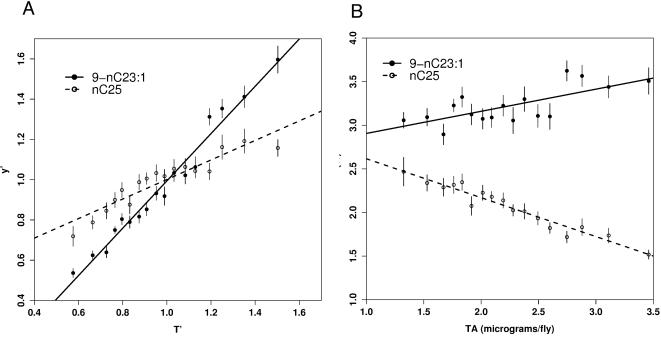
Test of RA model assumptions.(a) Plot of scaled abundance y′i
,j versus scaled total abundance T′i for monoene 9-C23∶1 (solid line) and n-alkane C25 (dashed line) in DD. Fitted slopes β′j are different from 1: slope β′j = 1.254 for 9-C23∶1 (s.e. = 0.0345, t = 7.37, df = 346, p<1e-12) and β′j = 0.483 for C25 (s.e. = 0.0365, t = −13.6, df = 345, p<1e-16). Each point is mean±1 s.e. of 20–22 observations over 24 hours. Abscissa and ordinate are dimensionless.(b) Plot of RA versus TA over 24 hours. RA is dimensionless, TA is µg/fly. 9-C23∶1 – filled circles, solid line; C25 open circles, dashed line. RA for C25 is less in flies with high total hydrocarbons, while RA for 9-C23∶1 is higher in such flies.